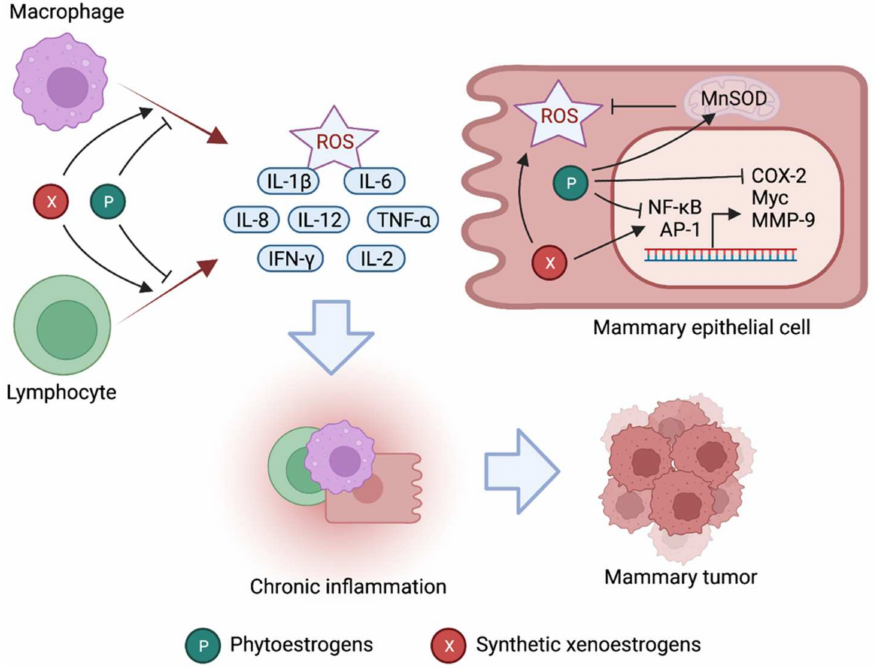
Figure 3. Inflammatory mechanisms differentially regulated by phytoestrogens and synthetic xenoe- strogens. Phytoestrogens promote anti-inflammatory responses in mammary tissue via inhibition of NF- κβ and AP-1, reduction of reactive oxygen species (ROS) in a manganese superoxide dismutase (MnSOD)-dependent manner, inhibition of COX-2, and reduced secretion of proinflammatory cy- tokines from innate and adaptive immune cells. On the other hand, synthetic xenoestrogens generally induce proinflammatory responses by activating NF- κβ signaling, increasing ROS generation, and enhancing the proinflammatory cytokine release from immune cells. Such responses can propagate chronic inflammation leading to breast cancer